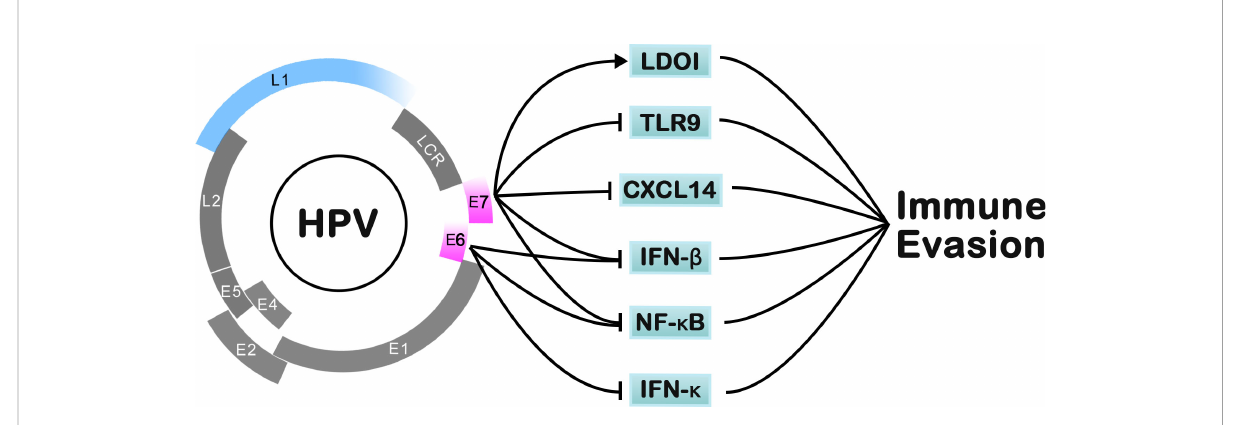
FIGURE 3 The pathways of HPV for immune-evasion